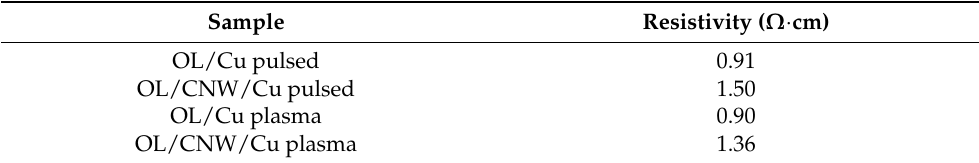
Table 2. Electrical resistivity ρ for copper